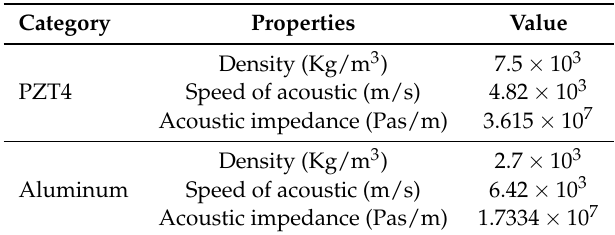
Table 1. Material properties